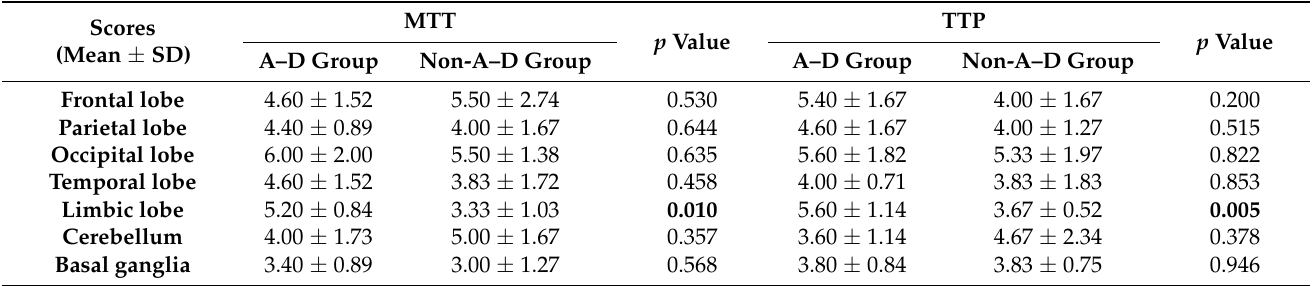
Table 4. The difference in hypoperfusion scores in different lobes of the brain between the anxiety and depression group and the non-anxiety and depression